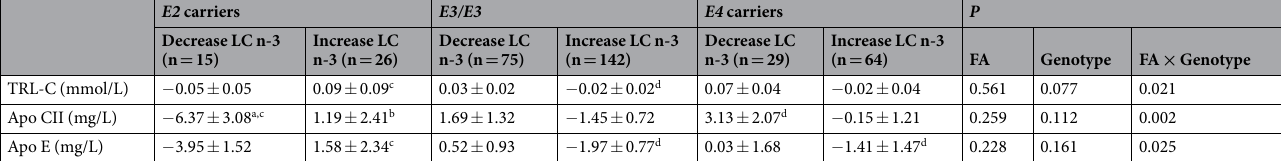
Table 4. Effects of significant change in plasma LC n-3 PUFA (%FA) and APOE genotype interactions on